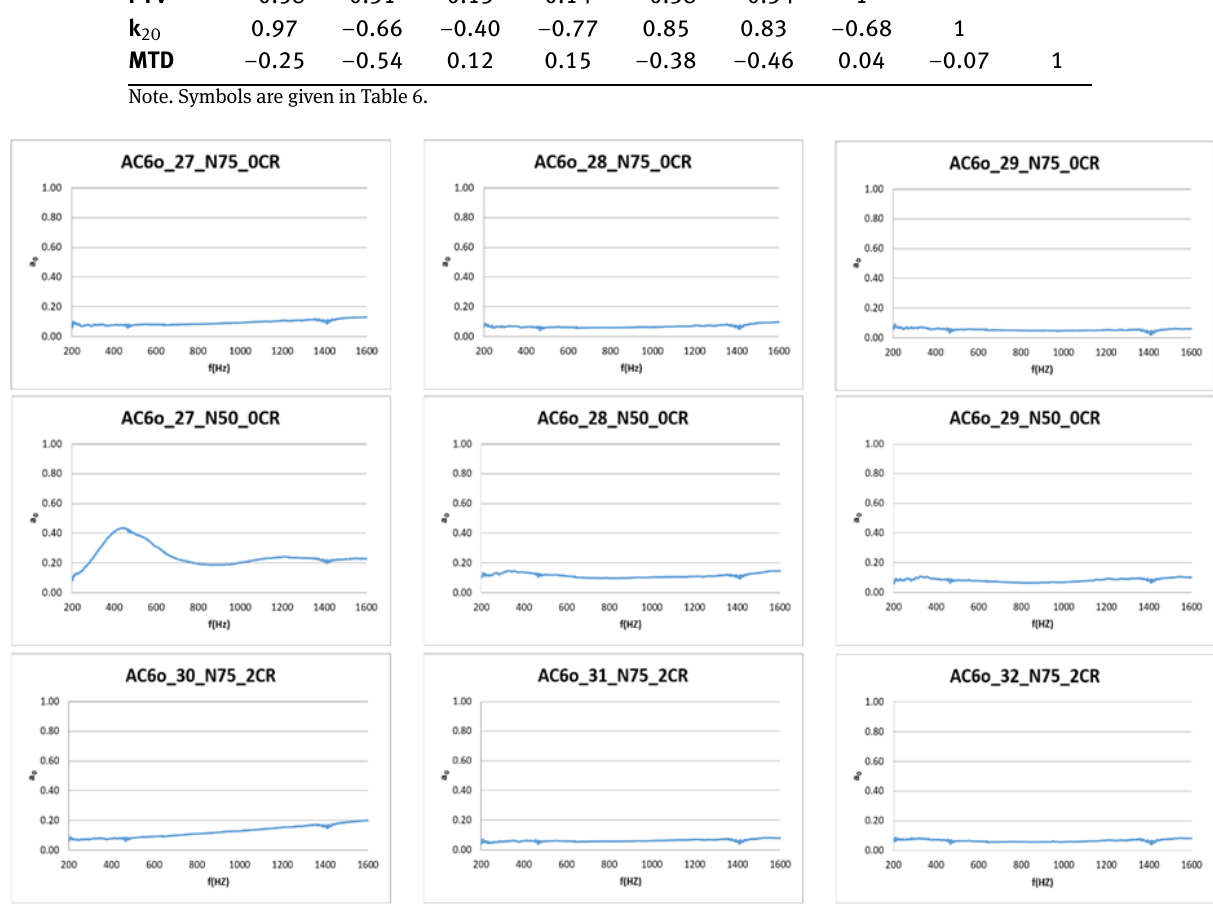
Figure 12: Sound absorption coeflcients